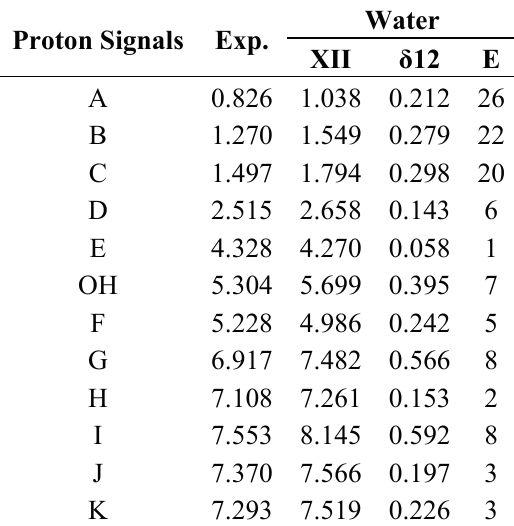
Table 3. Calculated and experimental data recorded at 293 K for losartan anion ( 1 ) Rotamer XII (isomer anti ); the following parameters were determined for their proton groups: experimental (Exp.) and calculated values of the chemical shifts (XII), absolute errors ( δ 12) and values of the relative percentage errors (E); calculated NMR shielding for proton H ref = 31.740 ppm for TMS (B3LYP/6-31G(d,p)/GIAO/CPCM; R 2 = 0.99, MAD = 0.28. Water Proton Signals Exp.